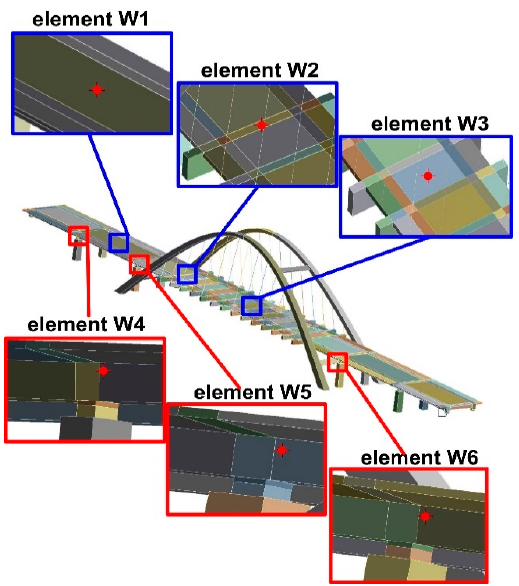
Figure 15. The location of the elements selected for discussing the results of the dynamic analysis. The dynamic responses of the viaduct, in terms of extremal principal stresses (maximal or minimal), calculated at the elements W1-W6 for shocks from both mining activity regions are compared in Figures 16–19. The results of the THA with the uniform and non-uniform excitation models are marked by the black and red solid lines, respectively. The results of the RSA and MSRS analysis are presented by the dashed and solid grey lines, respectively.